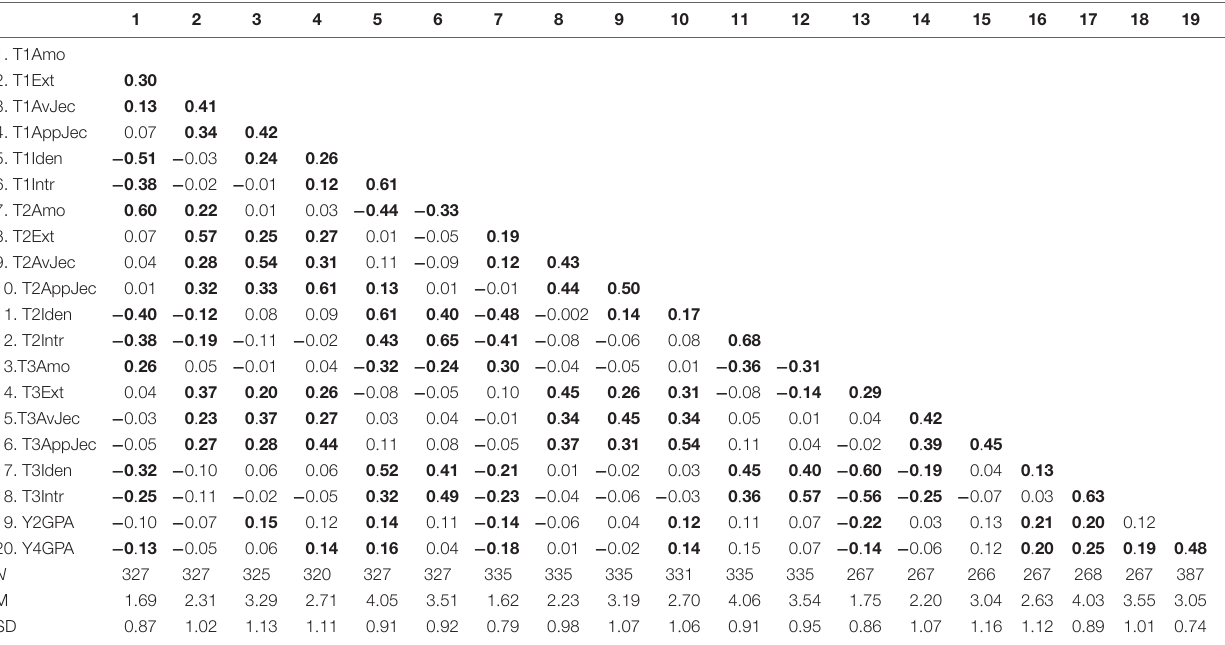
TABLE 2 | Correlations and descriptive statistics for the study variables.